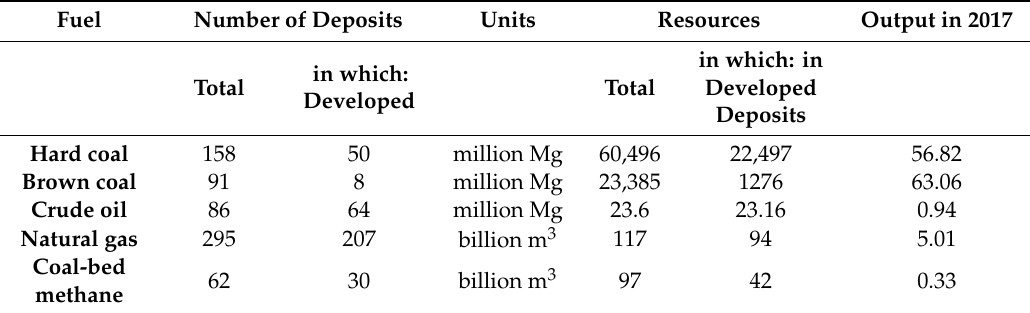
in which: in Total Developed Deposits